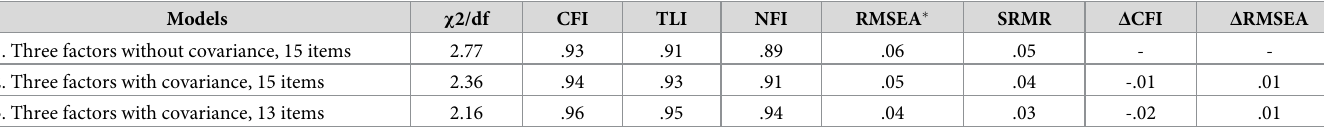
Table 5. Goodness-of-fit indicators of SEC-RU ( n = 537).